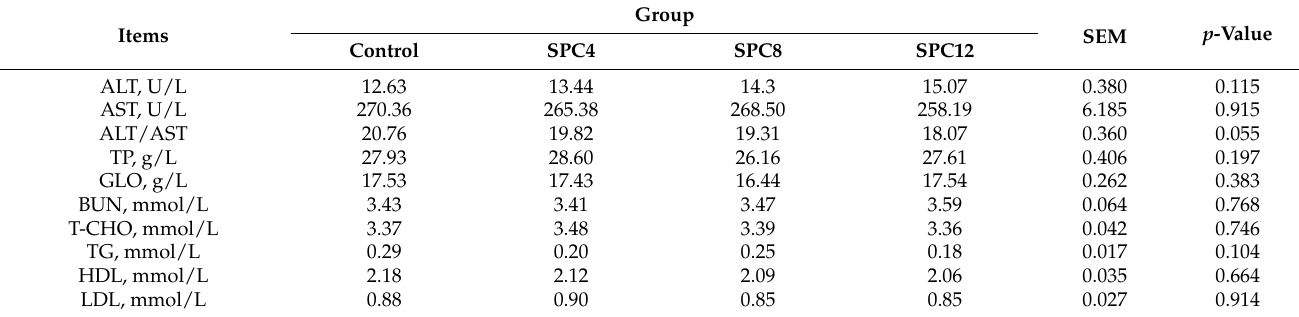
Table 4. Effects of dietary SPC on blood biochemical indices of broilers at 10